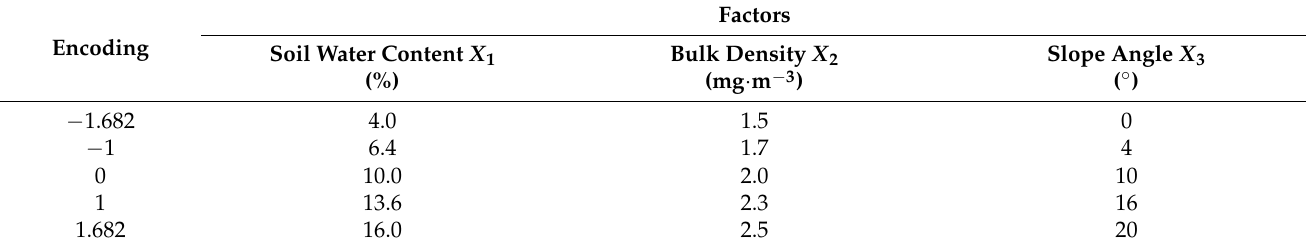
Table 4. Factors and levels of